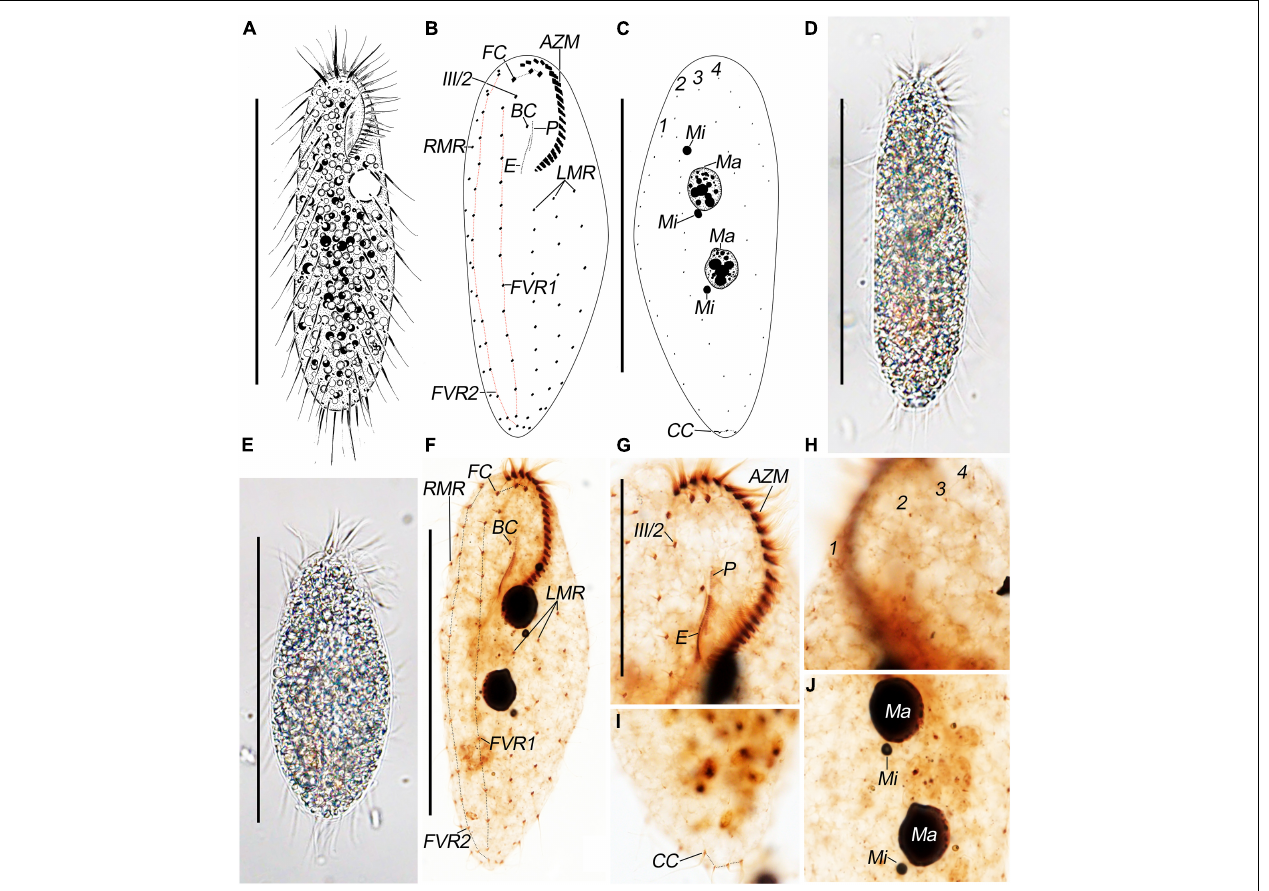
FIGURE 1 | Pseudosincirra longicirrata nov. gen. and nov. comb. morphology. (A) Live and (B,C) after protargol staining. Photomicrographs of (D,E) live and (F–J) after protargol staining. (A) Ventral view of a representative individual. (B,C) Ventral (B) and dorsal (C) views to demonstrate the infraciliature. (D,E) Ventral views of representative individuals to show different body shapes. (F) Ventral view to demonstrate the infraciliature. (G) Ventral view of the anterior end of cell. (H–J) Dorsal views to demonstrate the dorsal kineties (H) , caudal cirri (I) , and nuclear apparatus (J) . AZM, adoral zone of membranelles; BC, buccal cirrus; CC, caudal cirri; E, endoral; FC, frontal cirri; FVR 1, 2, frontoventral rows 1, 2; III/2, cirrus III/2; LMR, left marginal row; Ma, macronuclear nodules; Mi, micronuclei; P, paroral; RMR, right marginal row; 1–3, dorsal kineties; 4, dorsomarginal kinety. Scale bars = 100 µ m (A–F) and 40 µ m (G)